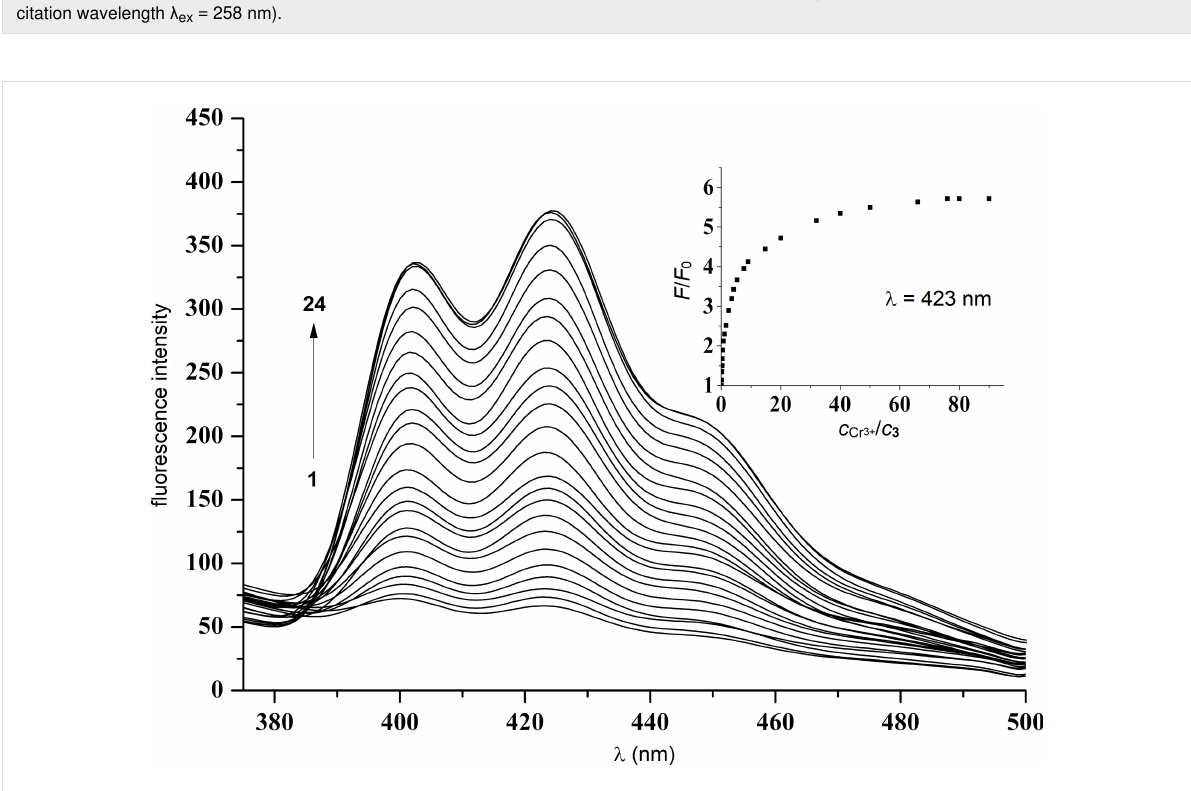
Figure 3: Fluorescence spectra of 3 ( c = 5 ⋅ 10 − 6 M) upon addition of various amounts of Cr 3+ . c Cr3+ for curves 1–24 (from bottom to top) were (0.00, 0.04, 0.08, 0.16, 0.24, 0.35, 0.49, 0.67, 0.80, 1.00, 1.45, 1.85, 2.30, 3.70, 4.50, 7.00, 10.00, 16.00, 20.00, 25.00, 33.00, 38.00, 40.00, and 45.00) ⋅ 10 − 5 M ( λ ex = 258